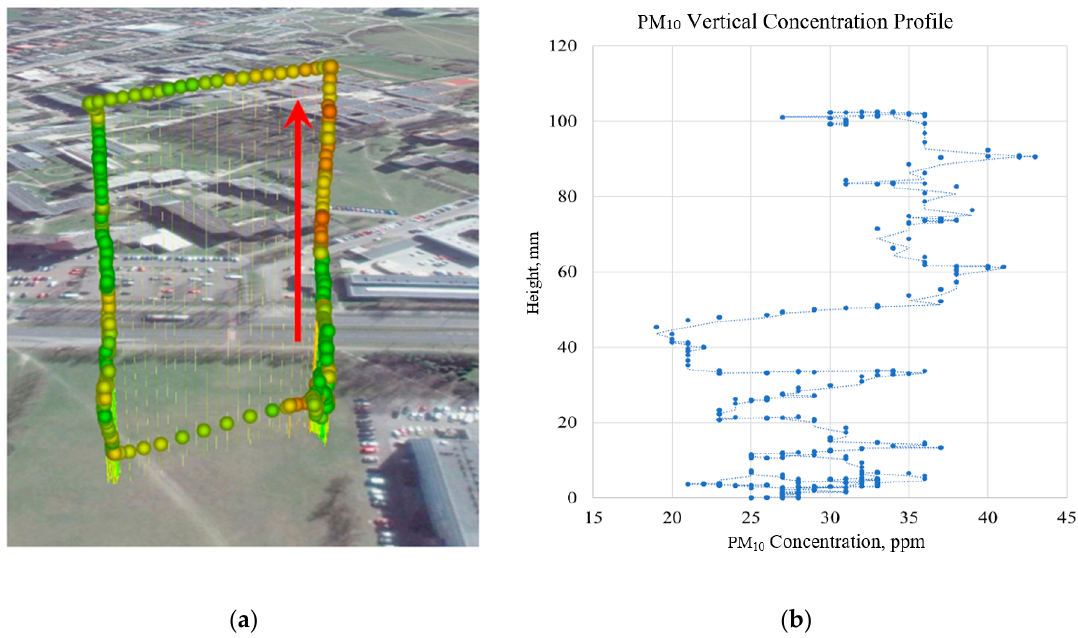
Figure 9. Flight route and measurement points visualization ( a ) for the vertical concentration profile of PM 10 ( b ) for location number 1 (see Figure 1)—red arrow indicates ascending flight and data for the visualization chart.